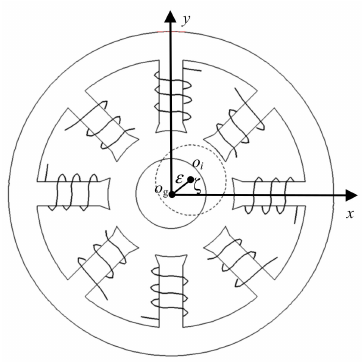
Figure 1. Section of single radial magnetic bearing–rotor system.